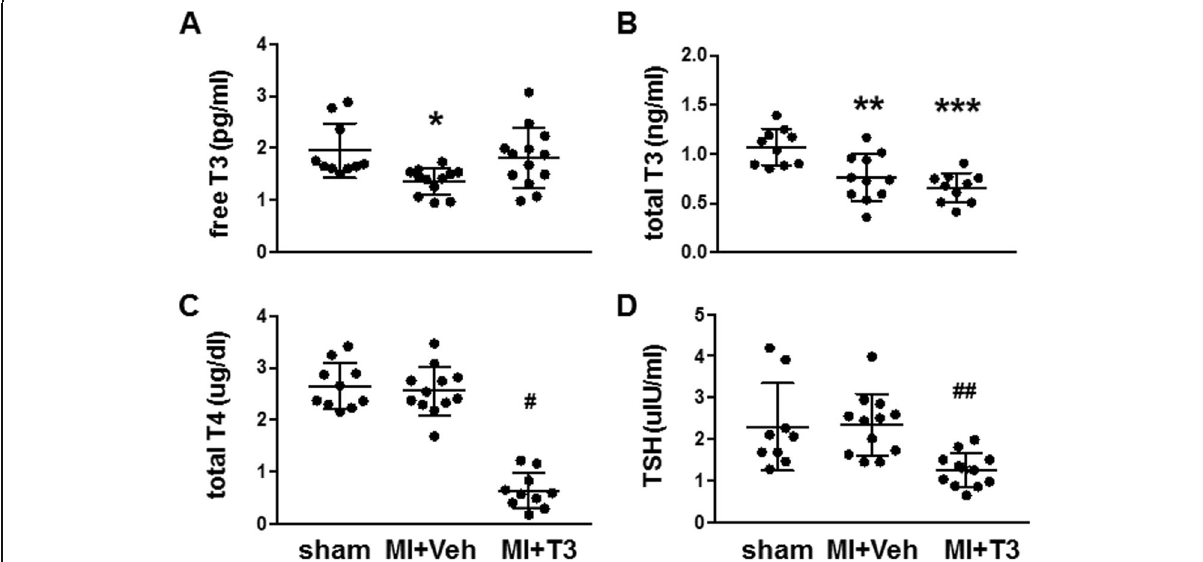
Fig. 1 Serum thyroid hormone concentrations. a free triiodo-L-thyronine (T3); b total T3; c total L-thyroxine (T4); d thyrotropin/thyroid stimulating hormone (TSH). Concentrations are indicated. Scatter plots represent individual rat hormone values, with lines indicating mean ± SD per group. n = 10 – 13 rats/group. One-way ANOVA followed by Tukey ’ s test of multiple group comparisons. * p < 0.05 vs sham; ** p < 0.01 vs sham; *** p < 0.001 vs sham; # p < 0.001 vs sham and MI + Veh; ## p < 0.01 vs sham and MI + Veh. MI, myocardial infarction; Veh,